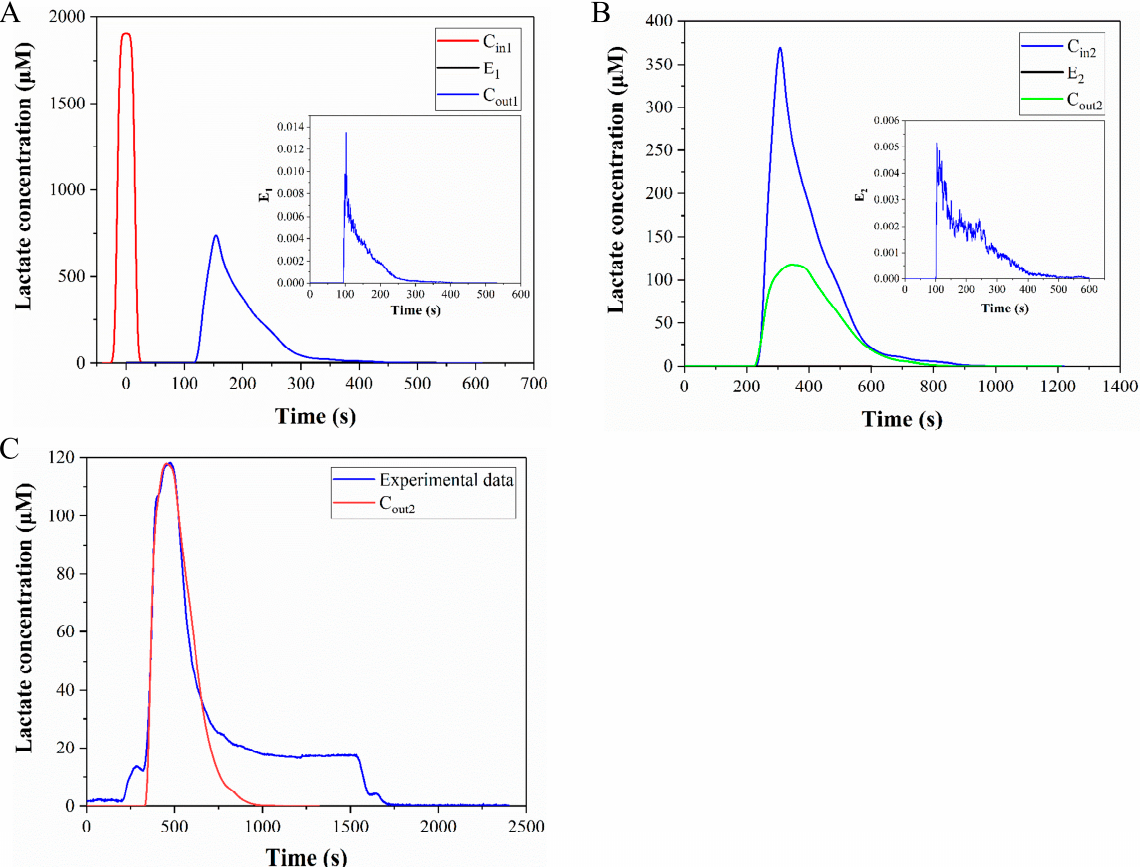
Figure 10. Change of lactate concentration in the flow process. ( A ) Change of lactate concentration during flow from point A to point B. ( B ) Change of lactate concentration during flow from point B to point C. ( C ) Comparison of the calculated results and the experimental data.